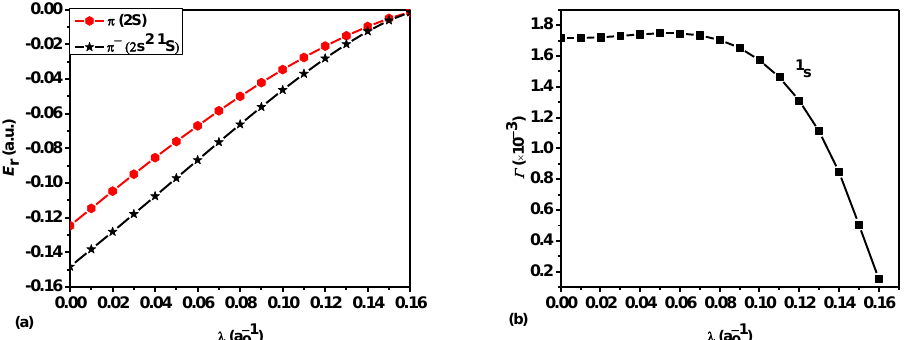
Figure 5. ( a ) Plot of the lowest 1 S e resonance energy E r of π − as a function of the screening parameter λ . ( b ) Plot of the corresponding resonance width Γ of π − as a function of the screening parameter λ .